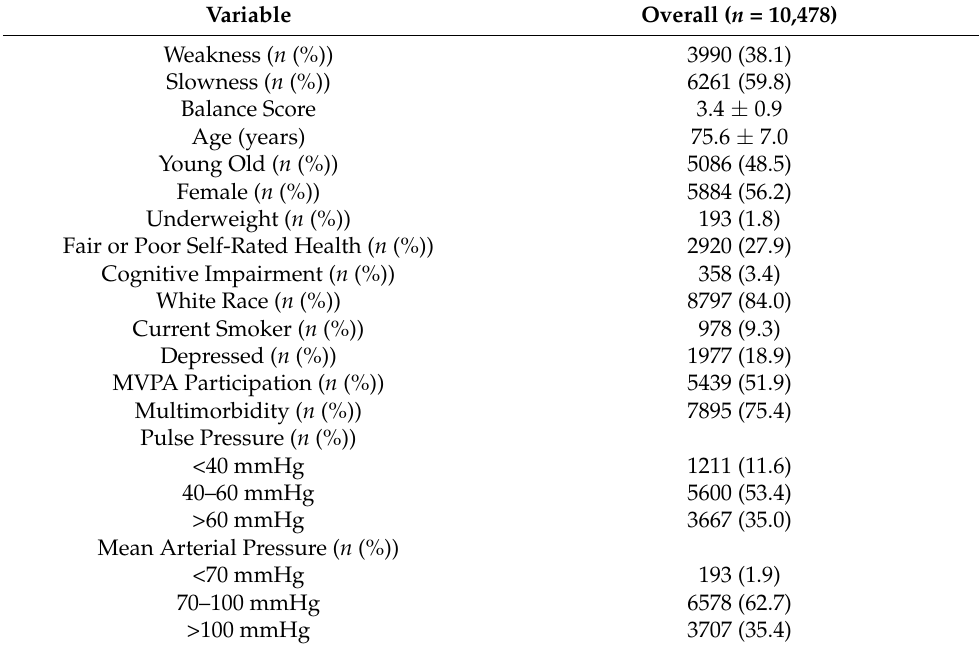
Table 1. Descriptive Characteristics of the